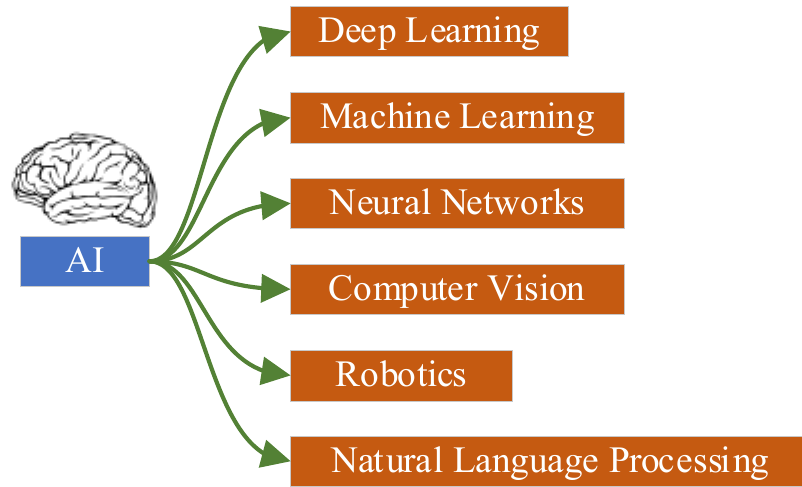
Figure 2. Six main categories of AI.